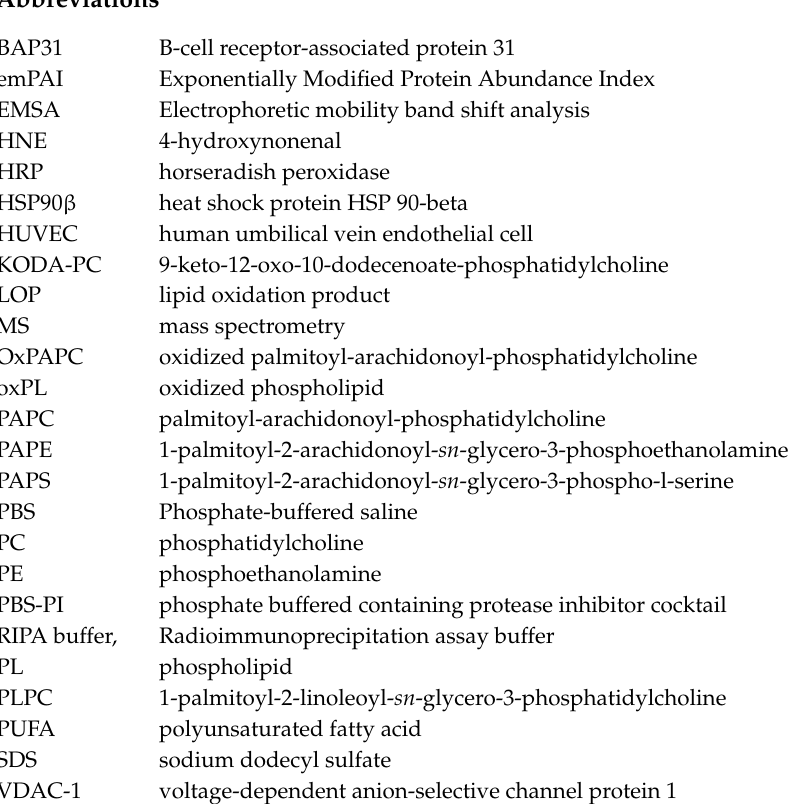
Figure S3 Selected MS/MS spectra of Aminopeptidase N. Figure S4 Selected MS/MS spectra of HSP90 β . Figure S5 Selected MS/MS spectra of Integrin alpha-2. Figure S6 Selected MS/MS spectra of ADP/ATP translocase